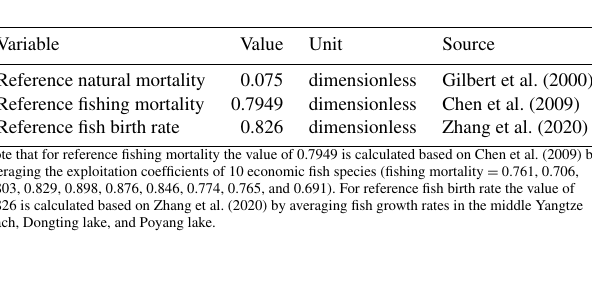
Table 3. Major parameters and their corresponding values in the fish